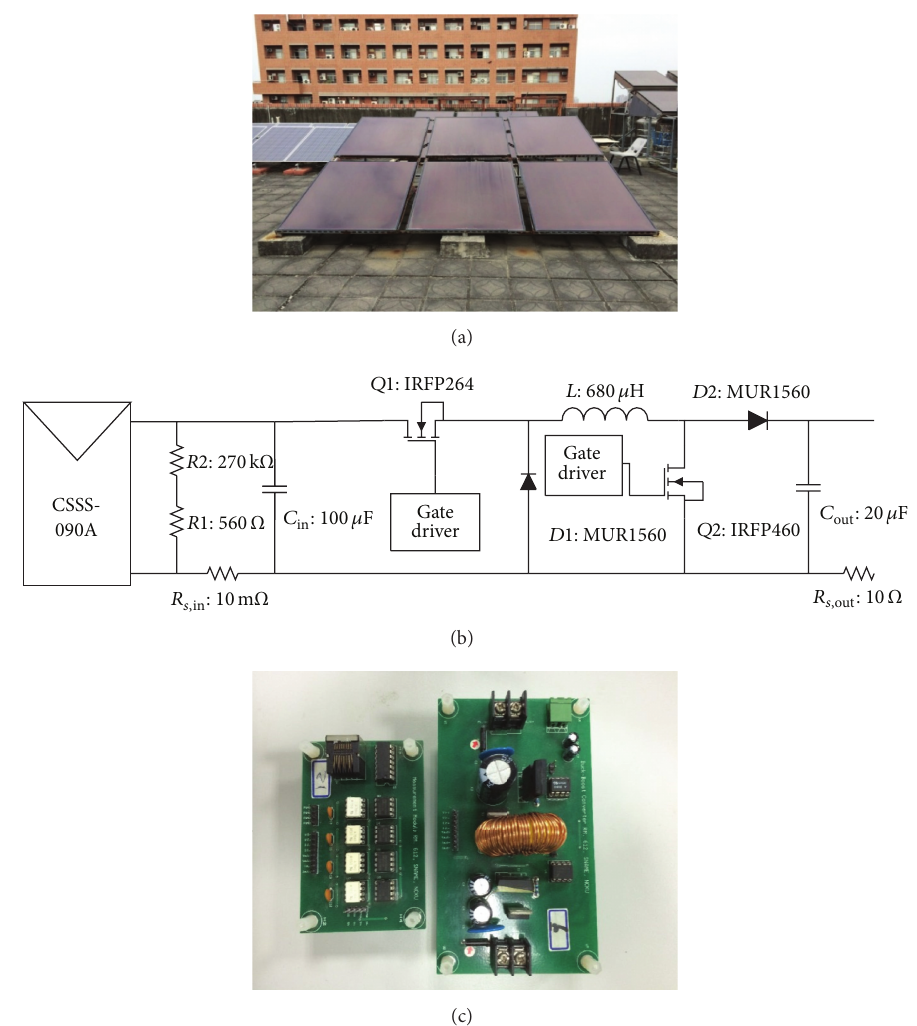
Figure 17: (a) Experimental site for the distributed PV system; (b) DC/DC converter circuitry design; (c) DC/DC converter prototype (right) and signal isolation board